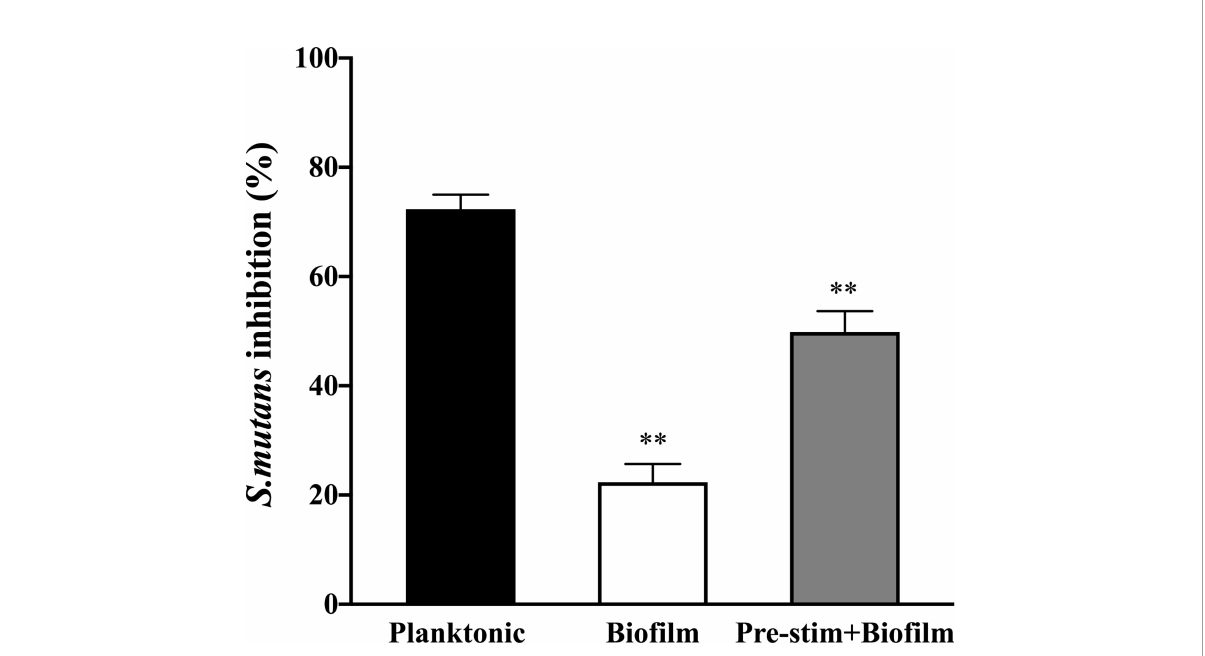
FIGURE 4 Survival advantage of S. mutans assembled into a bio fi lm community when facing neutrophils. Planktonic and bio fi lm S. mutans were co- cultured with neutrophils for 4h and bacterial burden were calculated by viable bacteria quanti fi cation assay. NETs were induced by incubation with PMA for 90min prior to infection with bio fi lm S.mutans as a subexperiment. Neutrophils exhibited strong killing activity against planktonic S. mutans (approximately 75%). However, when co-cultured with bio fi lm, neutrophils inhibited approximately 20% bacterial cells. Neutrophils pre- stimulated by PMA reversed the killing activity against bio fi lm. The results were depicted as mean ± SD (n=6). Statistical analysis was performed using a Student ’ s t-test with p <0.05. ** p <